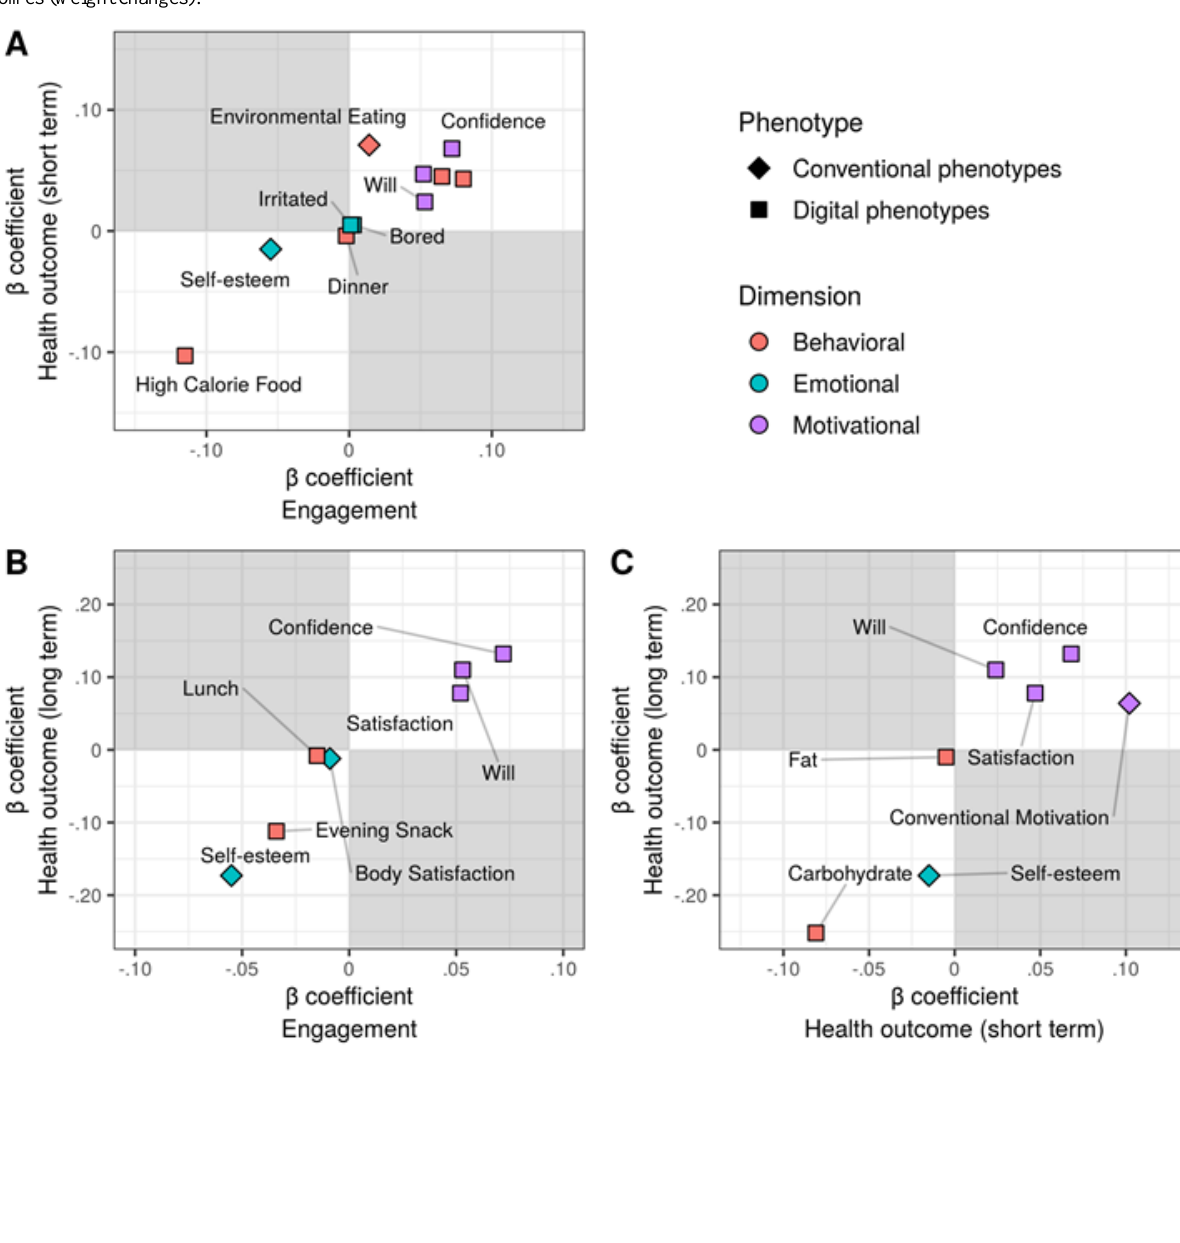
Figure 4. Common predictors between engagement and health outcomes for (A) health outcome (short term) versus engagement, (B) health outcome (long term) versus engagement, and (C) health outcome (long term) versus health outcome (short term). Each axis indicates the β estimate for predicting engagement and health outcomes. A positive β coefficient indicates a positive association with engagement but negative associations with health outcomes (weight